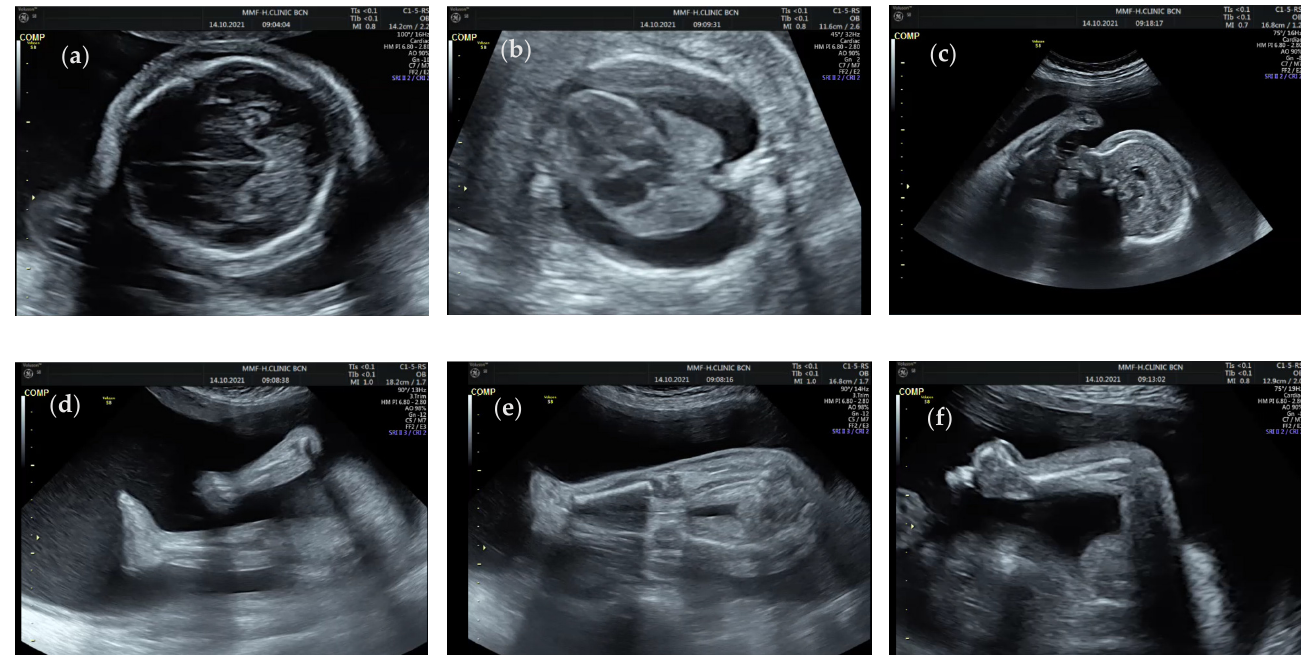
Figure 1. Transabdominal ultrasound images of the present case. Transabdominal ultrasound images of the present case showing ( a ) scalp edema, ( b ) subcutaneous edema and hydrothorax, ( c ) forehead edema, ( d , e ) lower extremity hyperextension, ( f ) upper extremity and hand contracture.